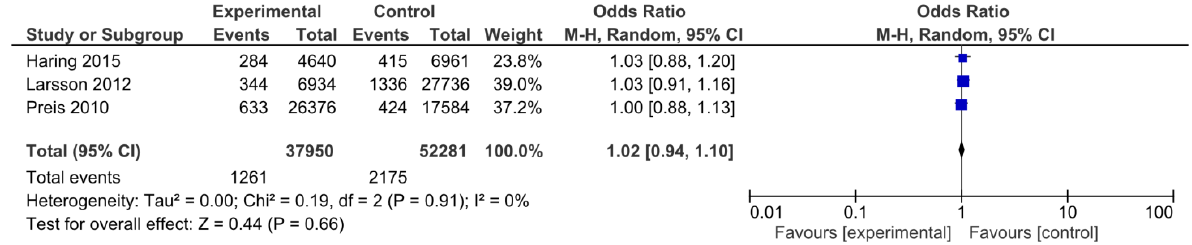
Figure 3. Forest plot for the association between HP intake and risk of cardiovascular mortality. [23,25,49,53,55,56,58] 3.3.2. Stroke